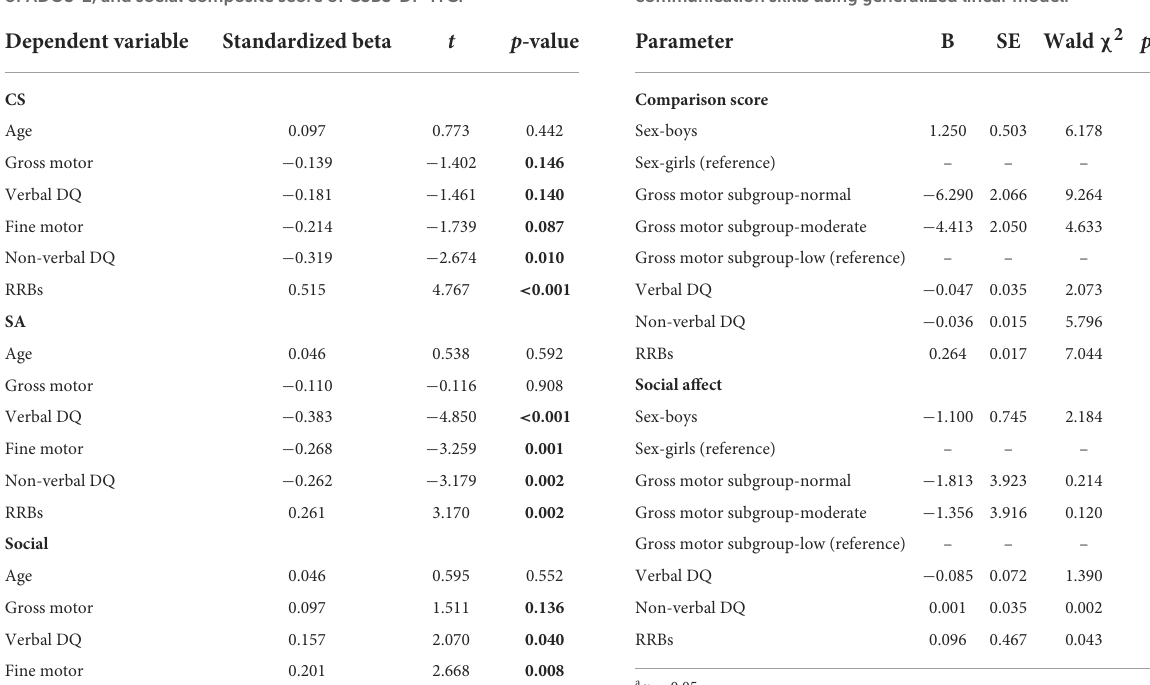
TABLE 3 Linear regression analyses of comparison score and SA score of ADOS-2, and social composite score of CSBS-DP-ITC.